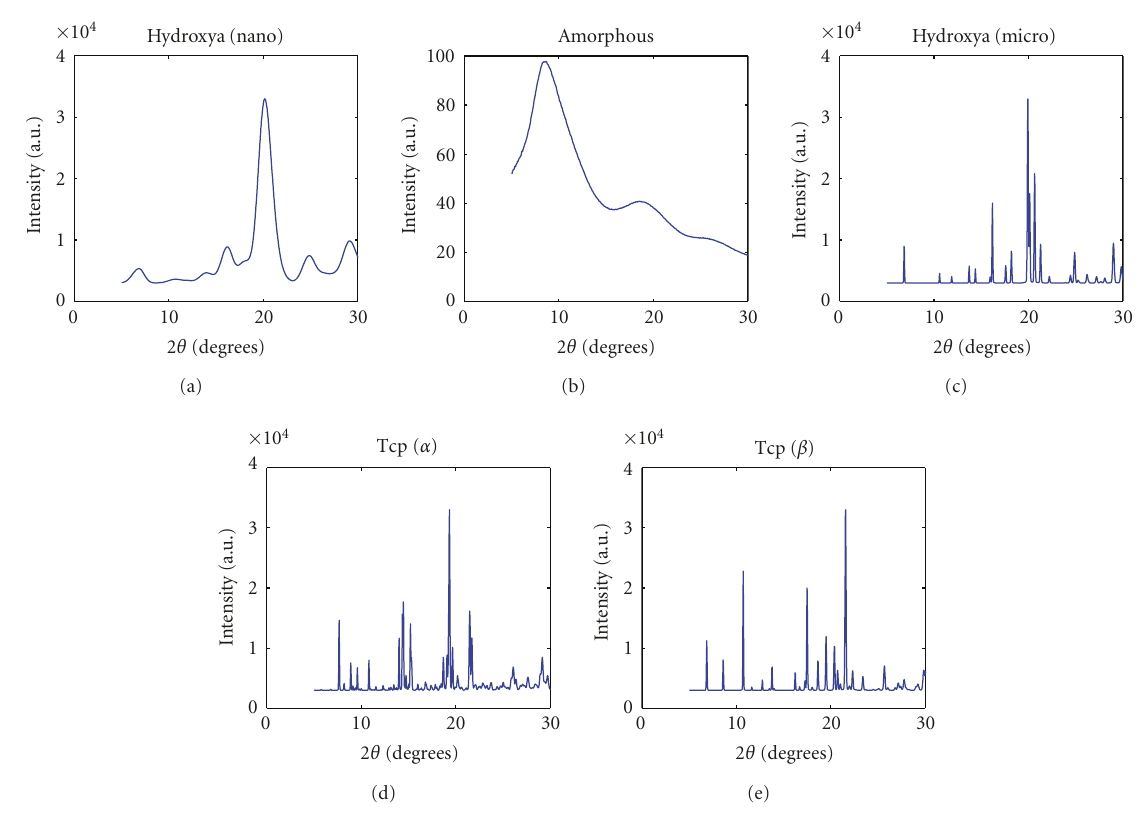
Figure 3: Intensity spectra of characteristic tissue